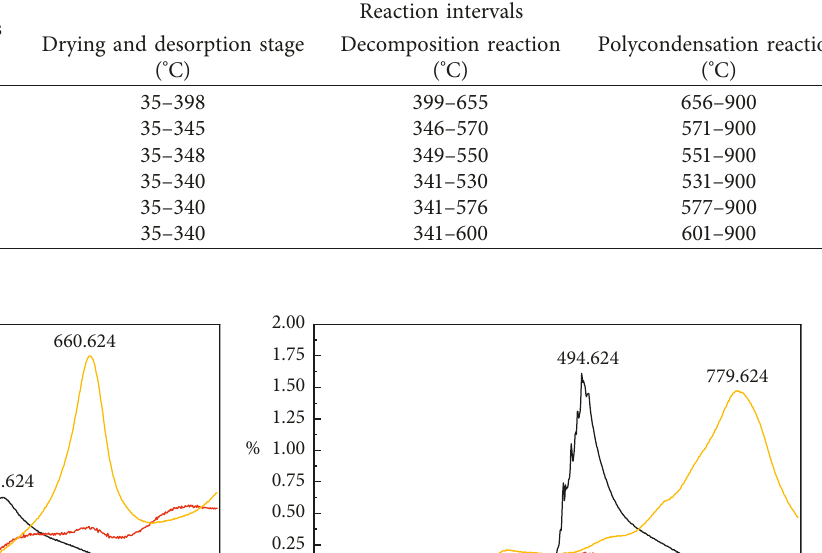
Table 2: The operating conditions of the experiments.